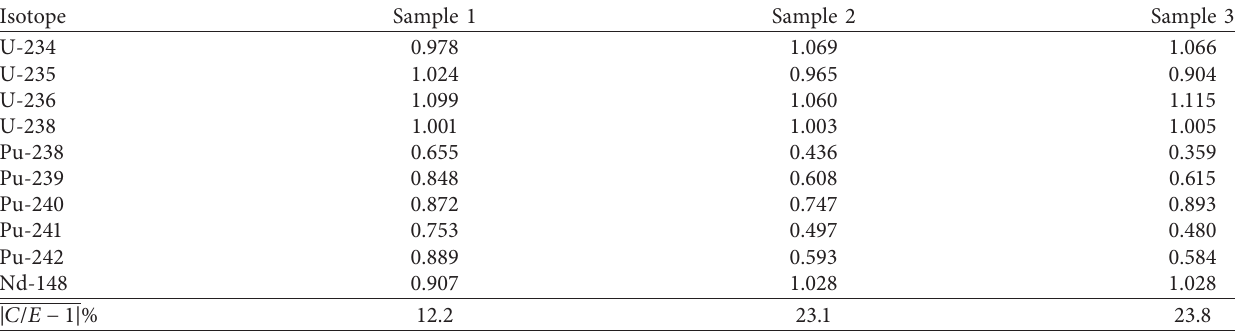
Table 2: Calculated/experimental (C/E) ratios for selected fuel isotopics in 2F2D1/F6. Isotope